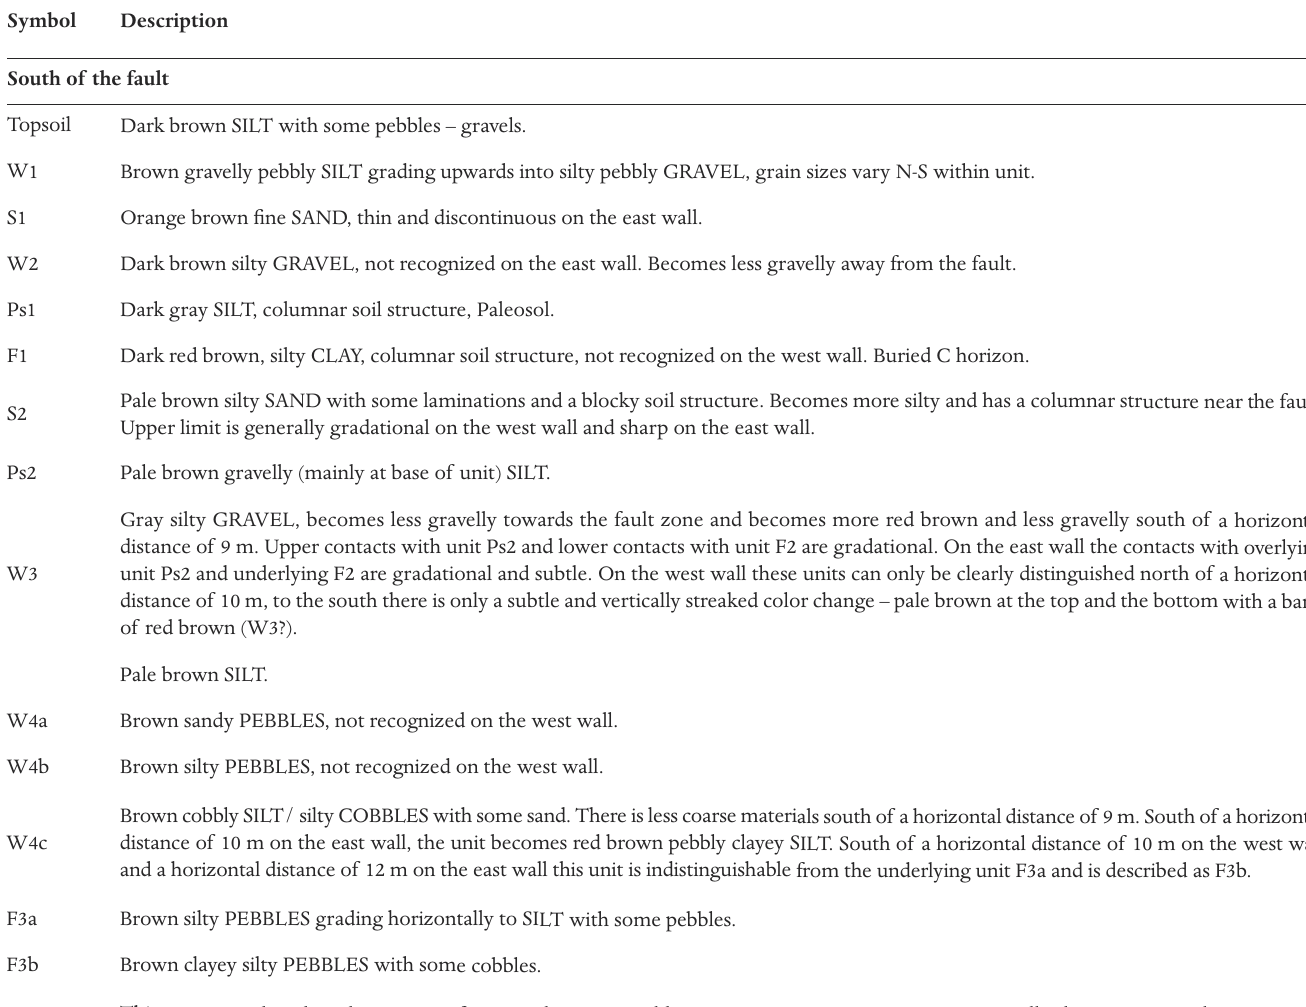
on the east wall.